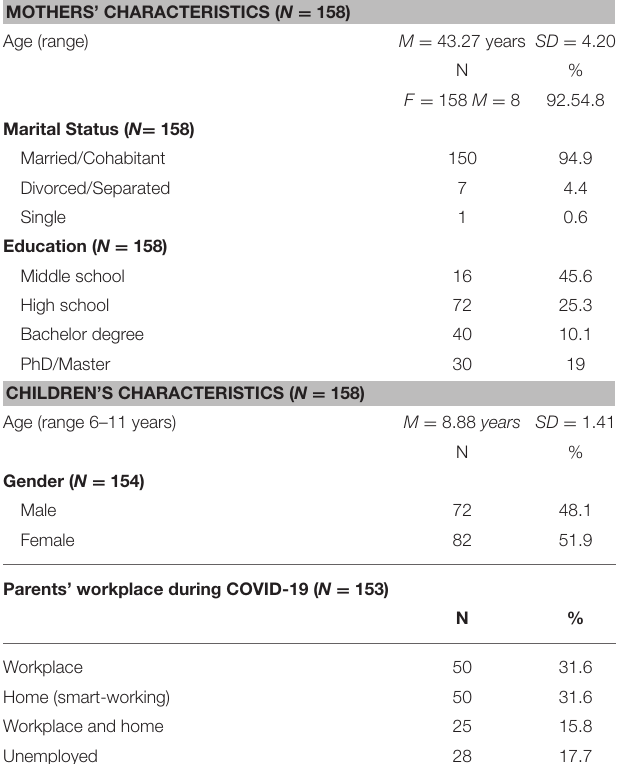
TABLE 1 | Participants’ socio-demographic